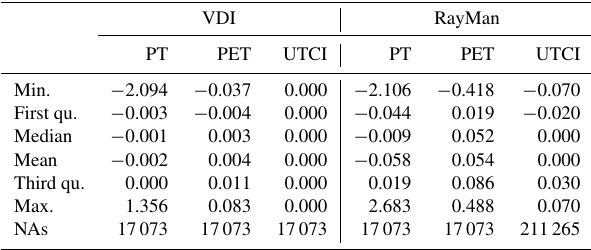
Table 6. Statistical overview over the comparison of the results gen- erated by the module for the PT, PET and UTCI thermal indices to those by the respective versions published in VDI guideline 3787 (VDI, 2008) and by the RayMan model. The last row provides the fail value count (“NAs”). VDI